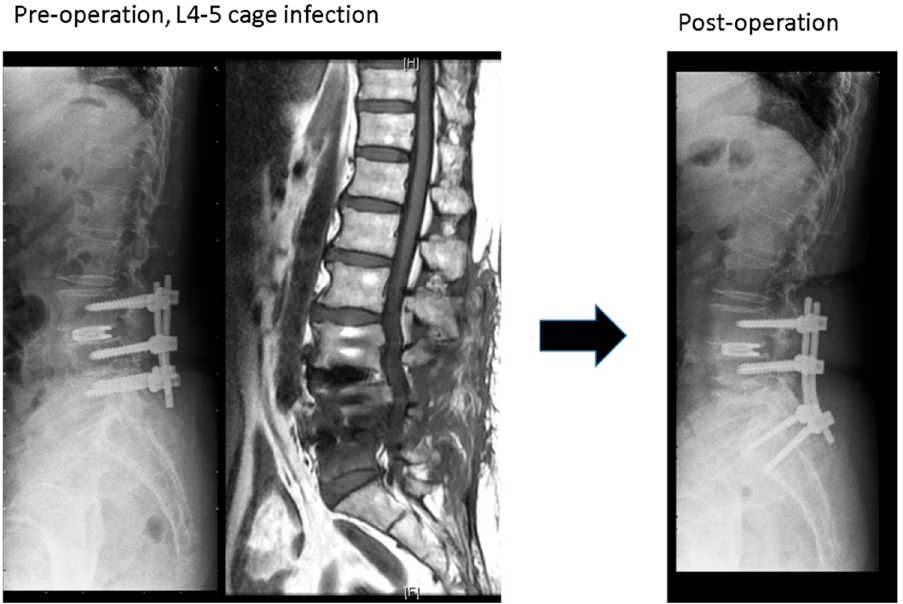
Figure 1. A case in the study group: L4-5 cage infection treated by removal of the L5 screws, extending screw to S1 with contralateral transforaminal debridement and fusion at L4-5 disc space.